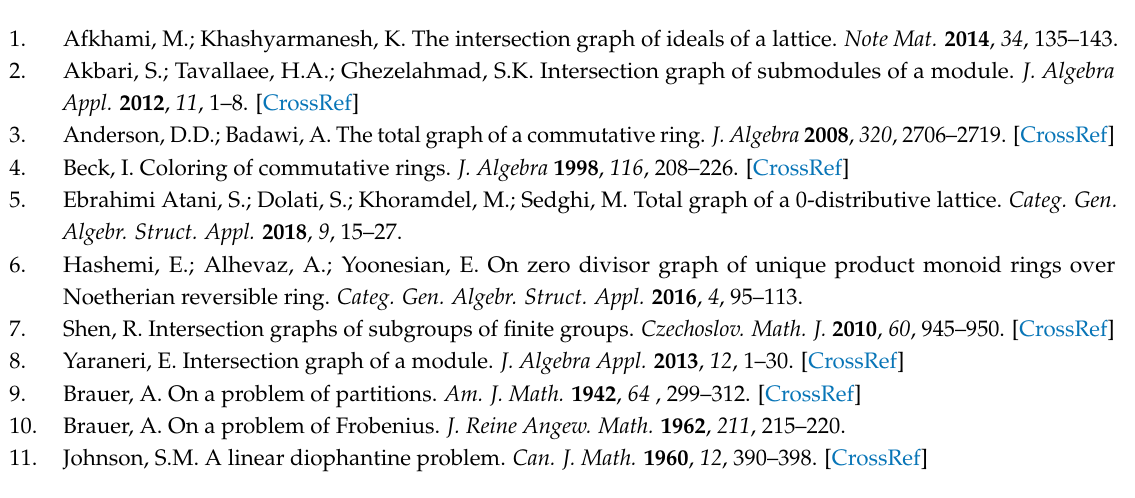
Figure 4. | g ( Γ ) | = m ( Γ ) =